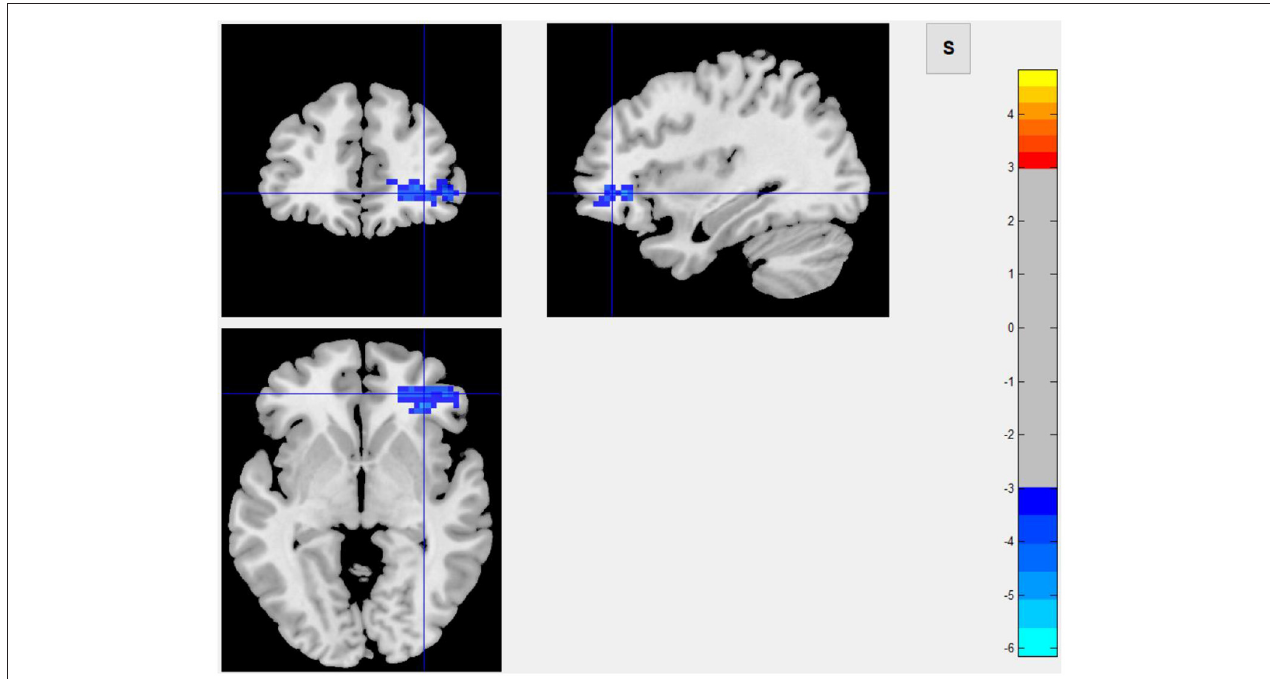
TABLE 4 | Alff and ReHo values in different brain regions in patients with and without post-stroke fatigue. Post-stroke Post-stroke fatigue ( n = 9) non-fatigue ( n = 7)